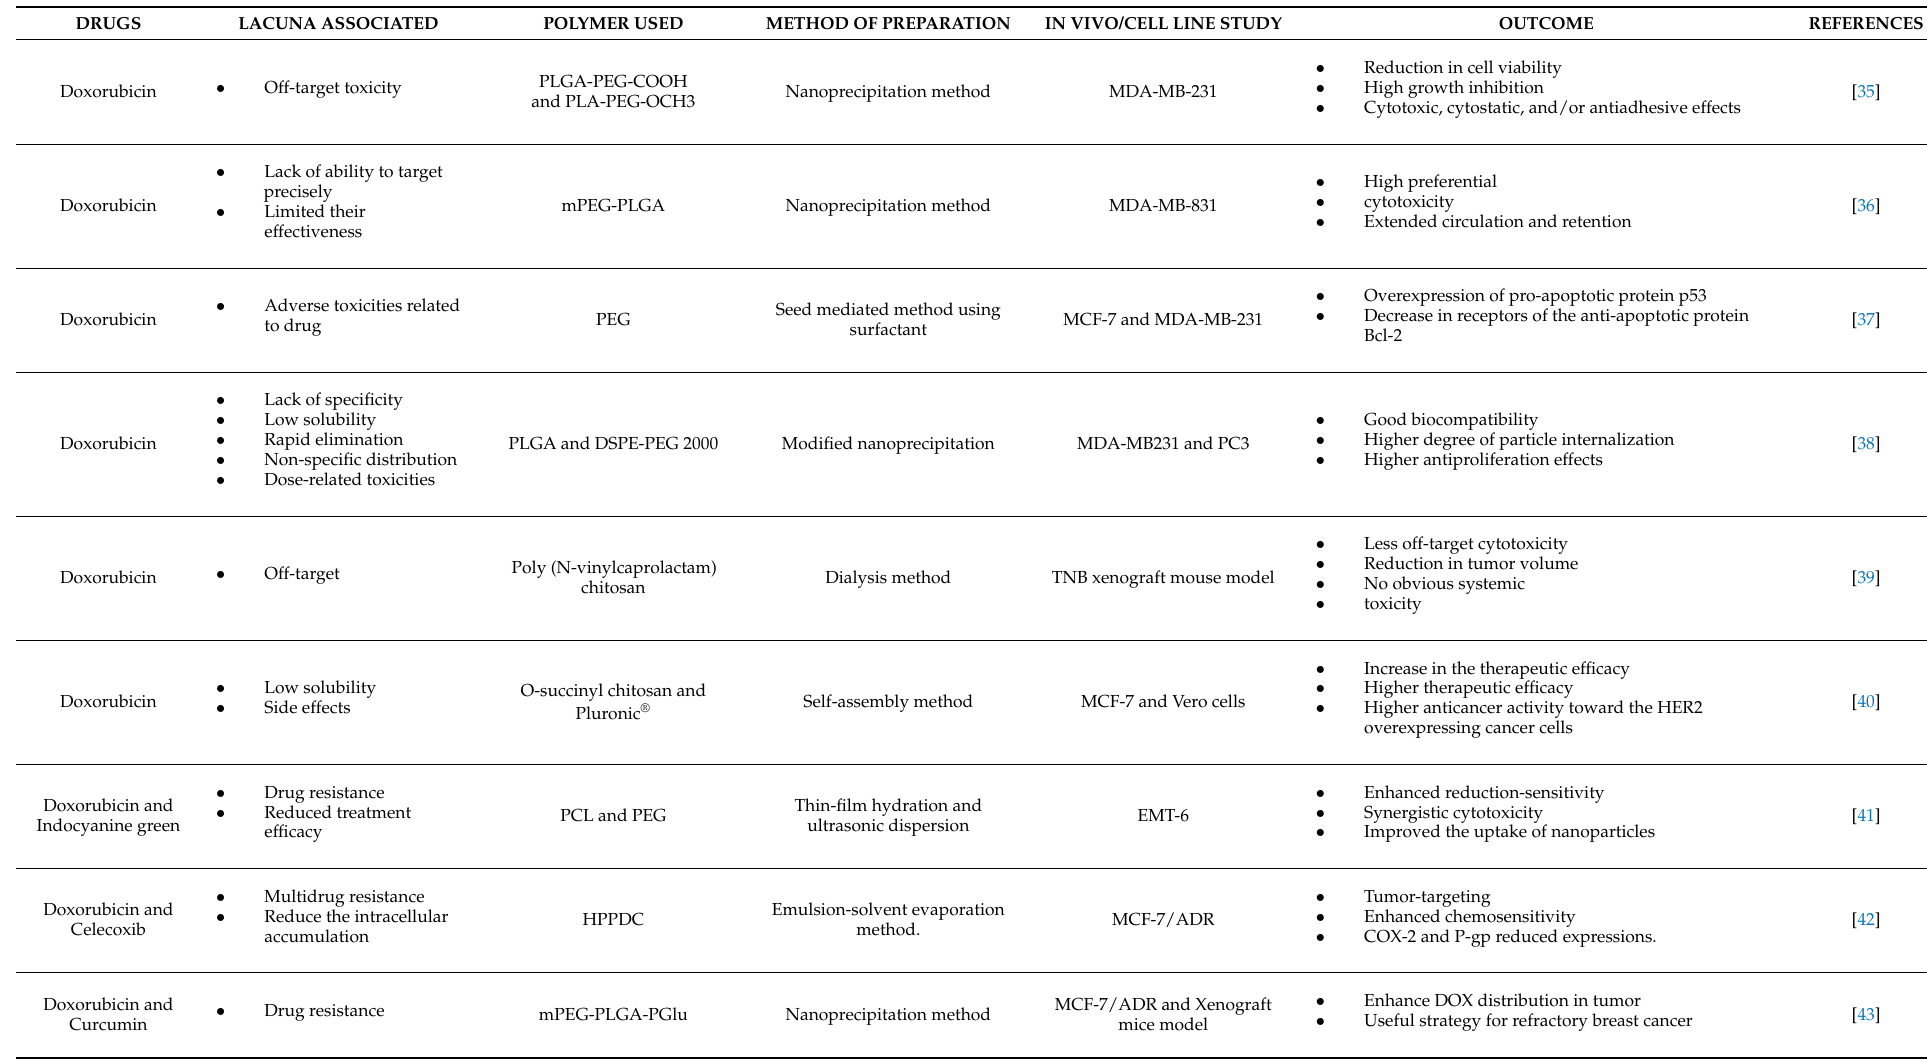
Table 3. Doxorubicin and their combination polymeric nanoparticles for breast cancer